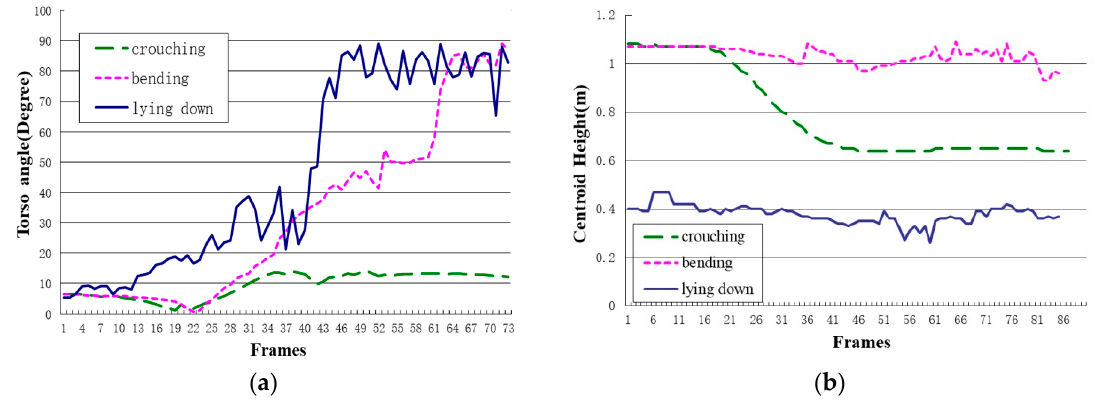
Figure 7. The data changing curve of the torso angle and centroid height. ( a ) The torso angle data changing curve; ( b ) the centroid height data changing curve.